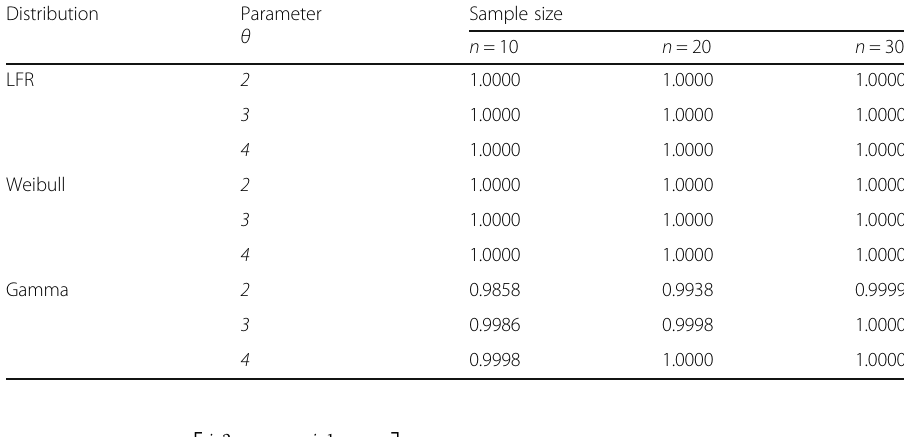
Table 4 below gives the critical values percentiles of 5(5)30(10), 81, 86 .